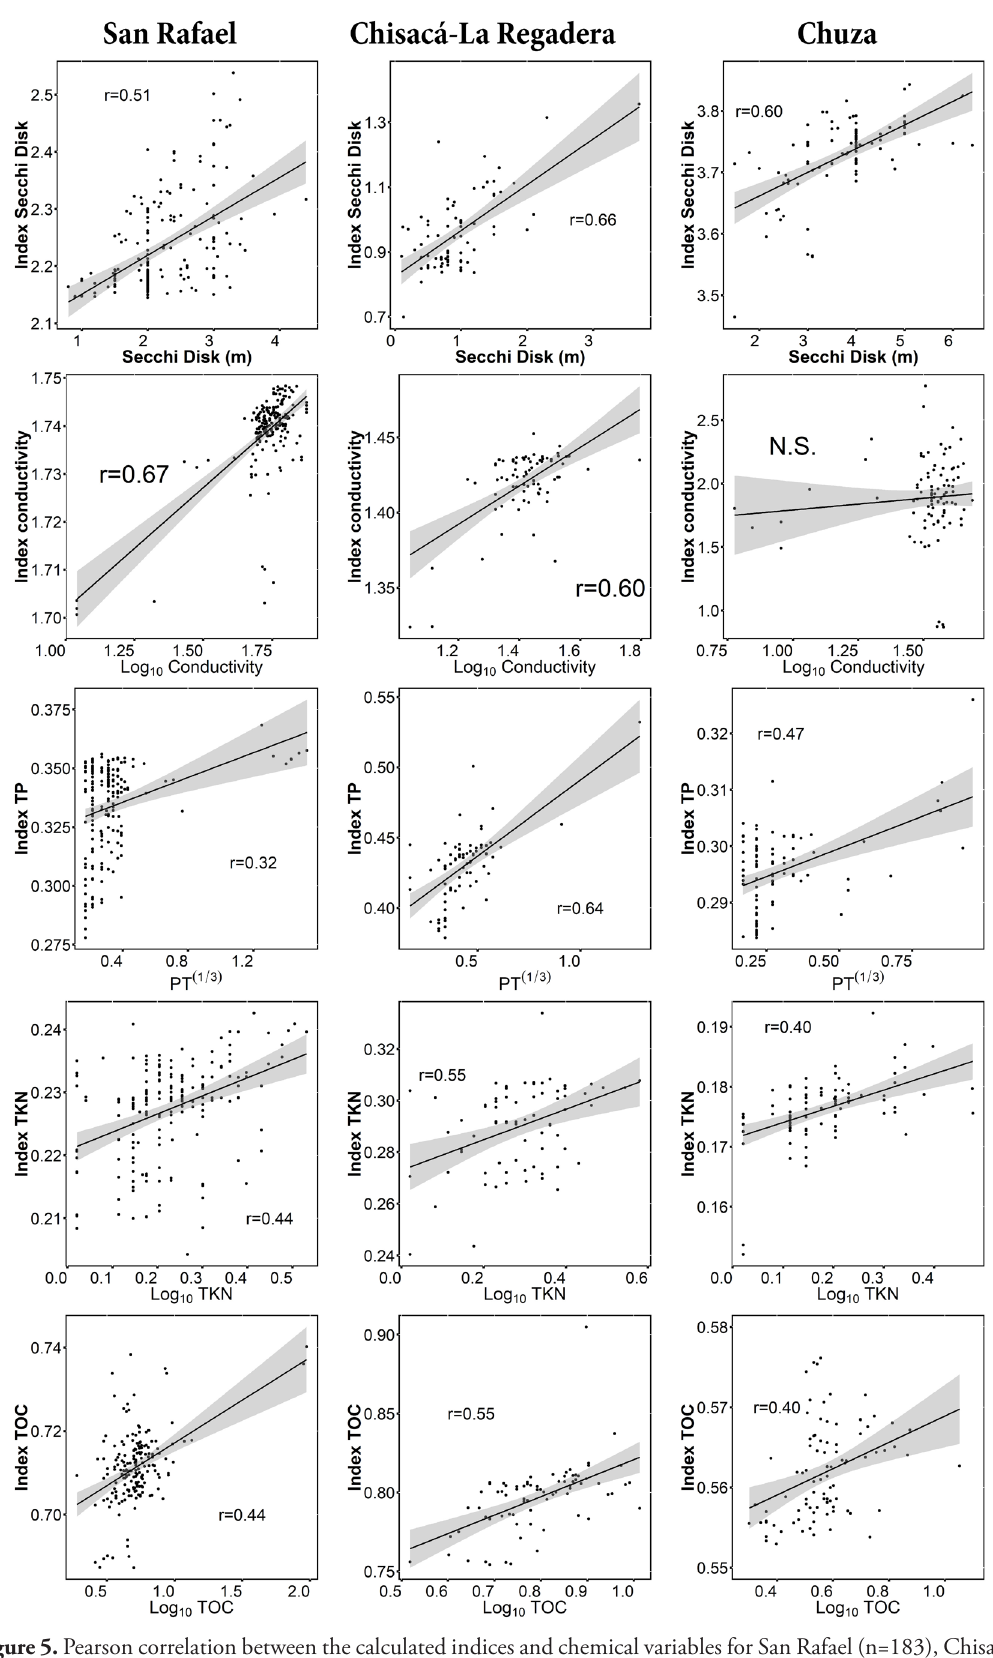
Figure 5. Pearson correlation between the calculated indices and chemical variables for San Rafael (n=183), Chisacá- La Regadera (n=76), and Chuza (n=93)